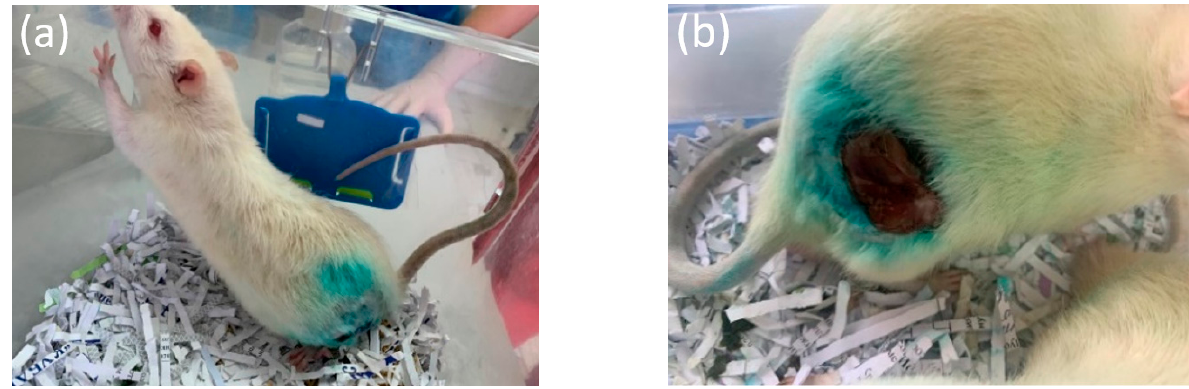
Figure 5. ( a , b ) Appearance of the animals and postoperative areas on the third day after implanta-